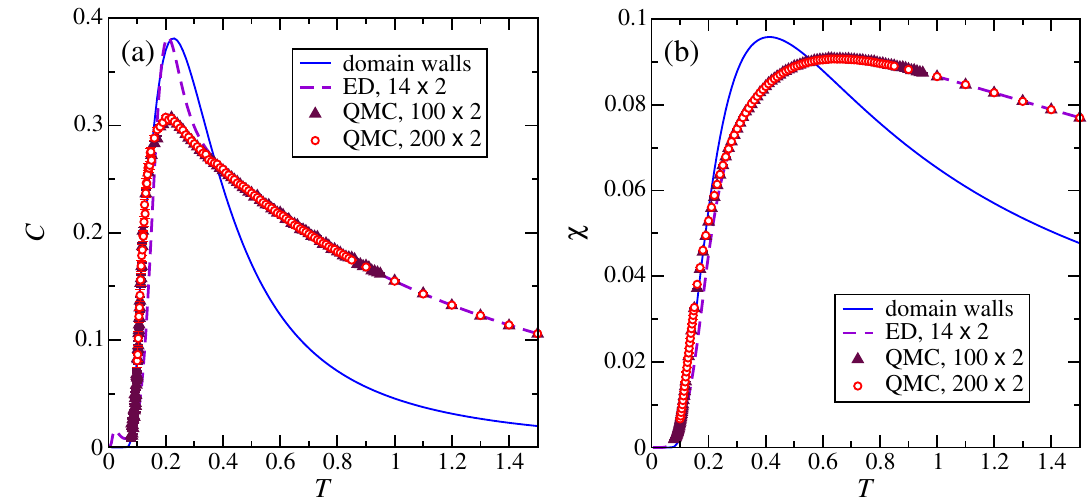
Figure 6: Magnetic specific heat, C , and susceptibility, χ , shown per spin for a fully frustrated ladder with rung coupling J ⊥ = 1.4 and inter-rung couplings J × = J (cid:107) = 1. These values lie very close to the critical line in Fig. 1. We compare QMC results obtained for ladders of L = 100 and 200 rungs with ED results for L = 14 and with a model of non-interacting domain